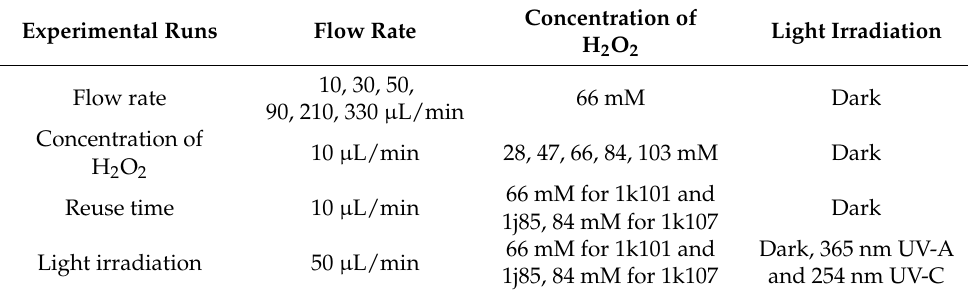
Table 1. Experimental runs and